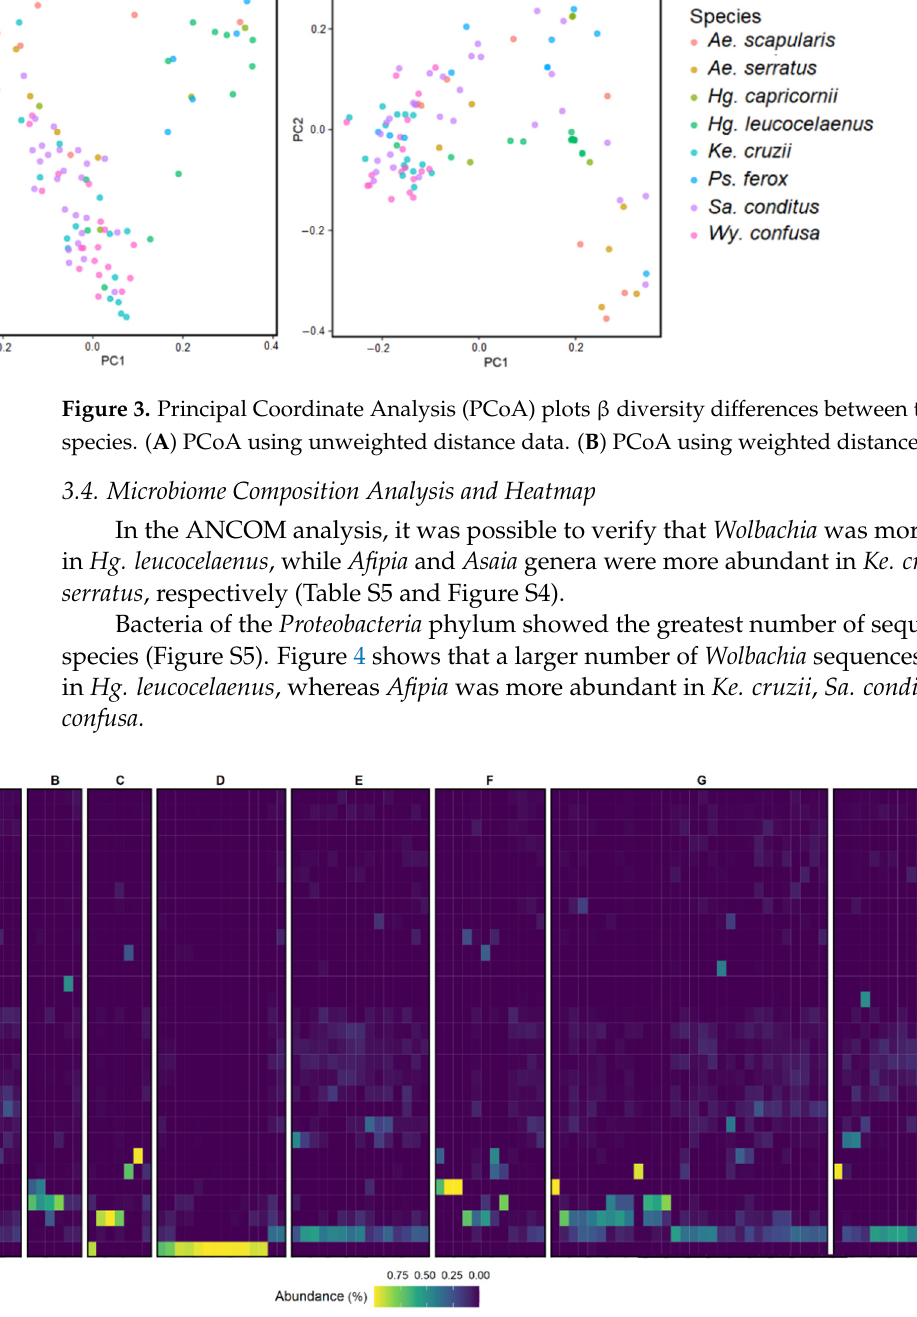
Figure 4. Heatmap of bacterial sequences with taxonomic assignment to genus level in each mosquito sample. Each row represents a bacterial taxon and each column corresponds a mosquito sample. Relative abundance data are assigned colors across a gradient from yellow (higher bacterial abundance) to purple (lowest bacterial abundance). ( A ) corresponds to samples of the species Ae. scapularis ; ( B ) corresponds to samples of the species Ae. serratus ; ( C ) corresponds to samples of the species Hg. capricornii ; ( D ) corresponds to samples of the species Hg. leucocelaenus ; ( E ) corresponds to samples of the species Ke. cruzii ; ( F ) corresponds to samples of the species Ps. ferox ; ( G ) corresponds to samples of the species Sa. conditus and ( H ) corresponds to samples of the species Wy. confusa .